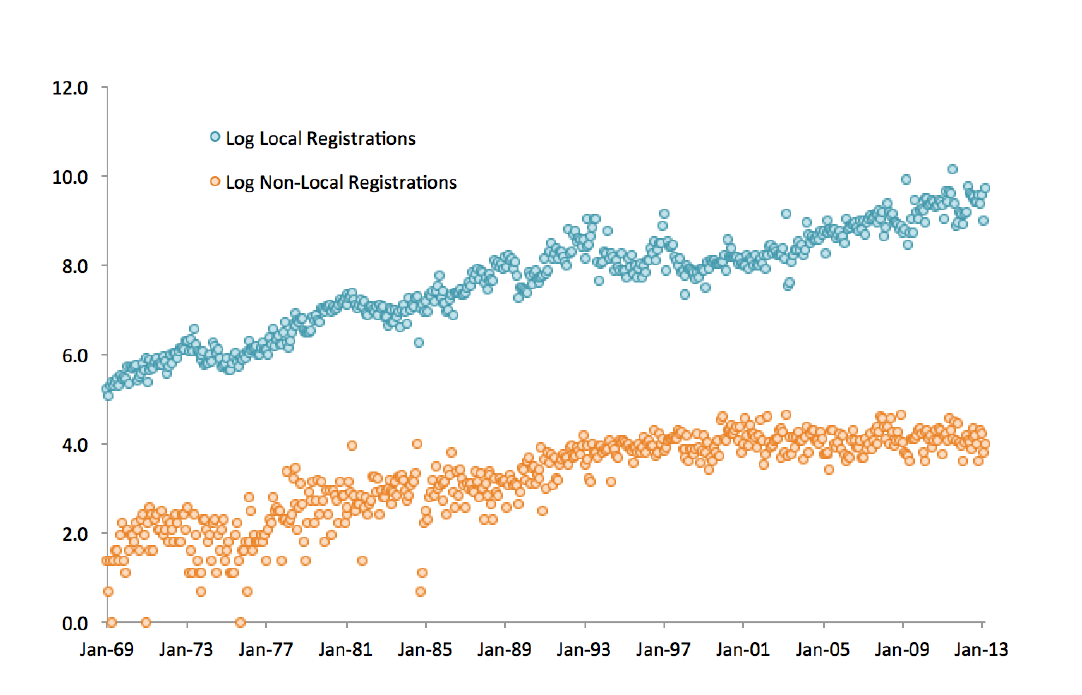
Figure 2: Comparing Monthly (Log) Local and Non-local New Registrations 1975-2013 parable economy, human population, and